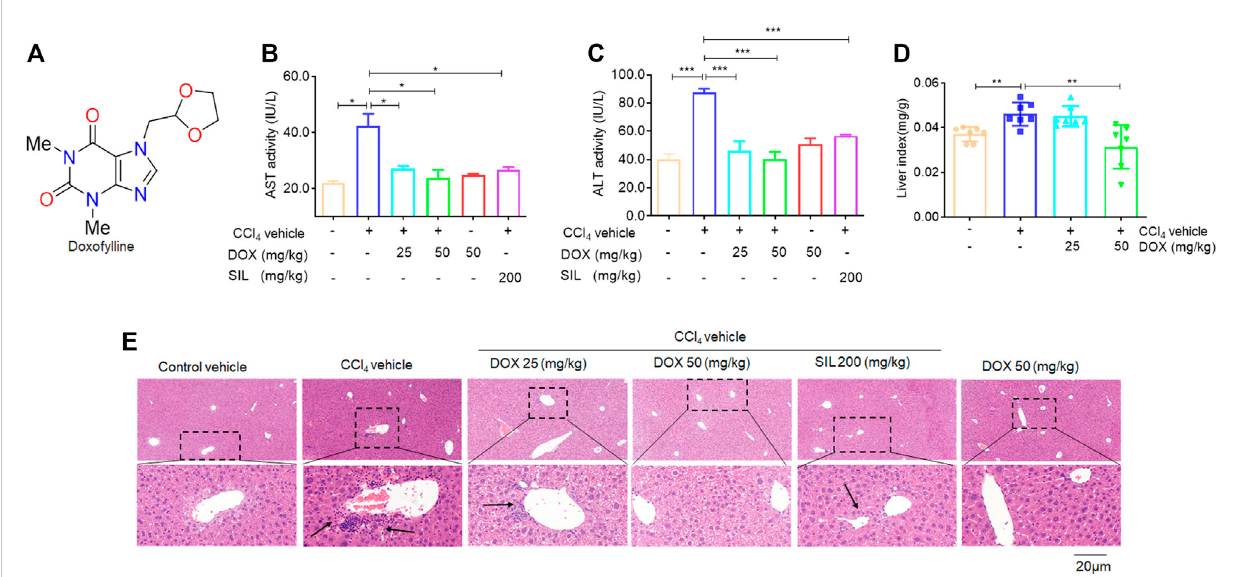
Effects of DOX serum ALT/AST activity and liver H&E staining. (A) The chemical structures of DOX. (B) AST activity. (C) ALT activity. Data were expressed as means ± SEM ( n = 3). (D) Liver index ( n = 7). (E) Liver H&E staining. Typical images were chosen from each experimental group. (original magni fi cation ×400, upper images; partial enlarged pictures, down images). * p < 0.05; *** p <